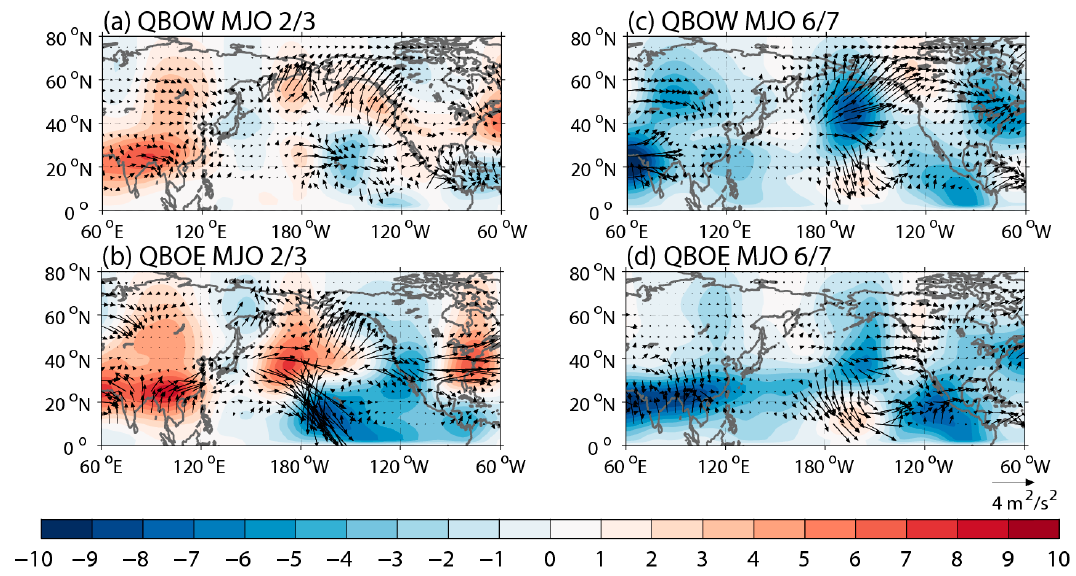
Figure 3. Composite stream function anomalies (shading, ×10 6 m 2 /s 2 ), and wave activity flux (vector, scale at the right bottom) at 300 hPa averaged from 10 to 14 days after the MJO phase 2/3 in QBOW ( a ) and QBOE ( b ) years. Subplots ( d )–( f ) are the same as ( a )–( c ) but for the MJO phase 6/7.